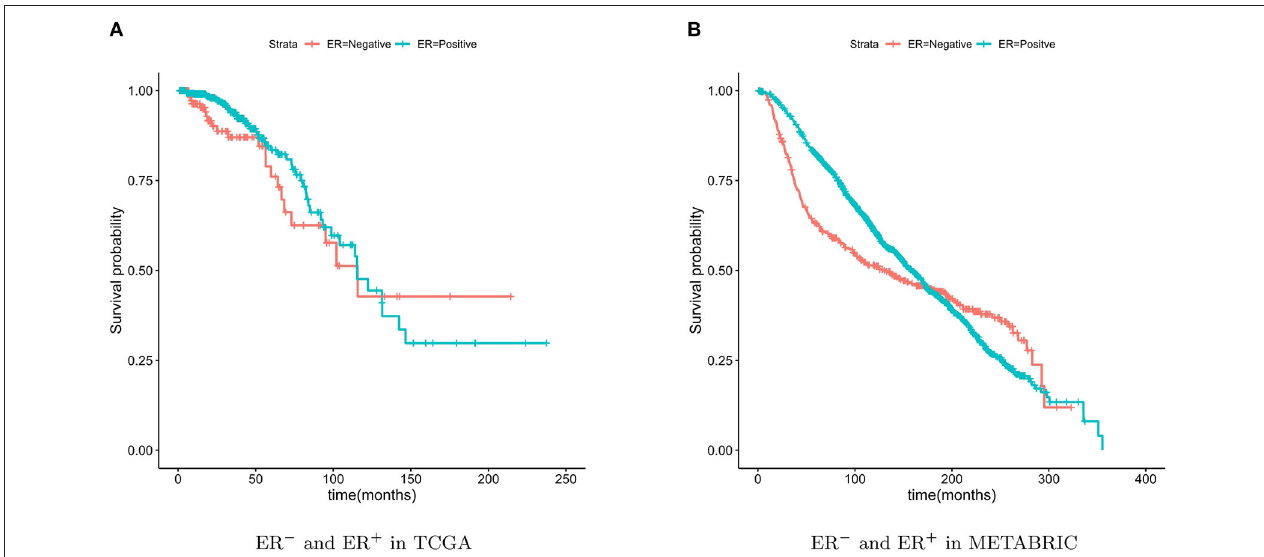
FIGURE 2 | Kaplan-Meier survival curves of ER − and ER + . The ER − breast cancer patient have a poor prognosis in the short term and a relatively good prognosis in the longer